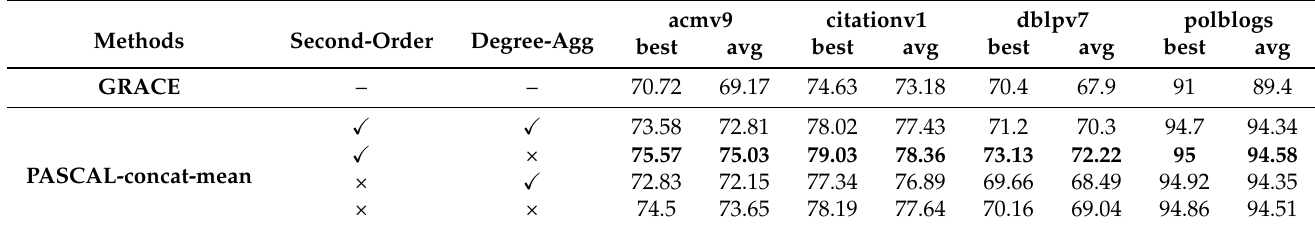
Table 5. The performance of different variants of PASCAL. “second-order” indicates whether to use the second-order motif when constructing the subgraph. “degree-agg” indicates whether to consider node degree when calculating motif embedding. Here check mark means consider it and cross means not use it. “PASCAL-concat-mean” represents the PASCAL-concat variant in Section 4.4, which uses the mean aggregator in Section 4.3 to aggregate different types of motif prototypes. Bold numbers represent the best results on different datasets.